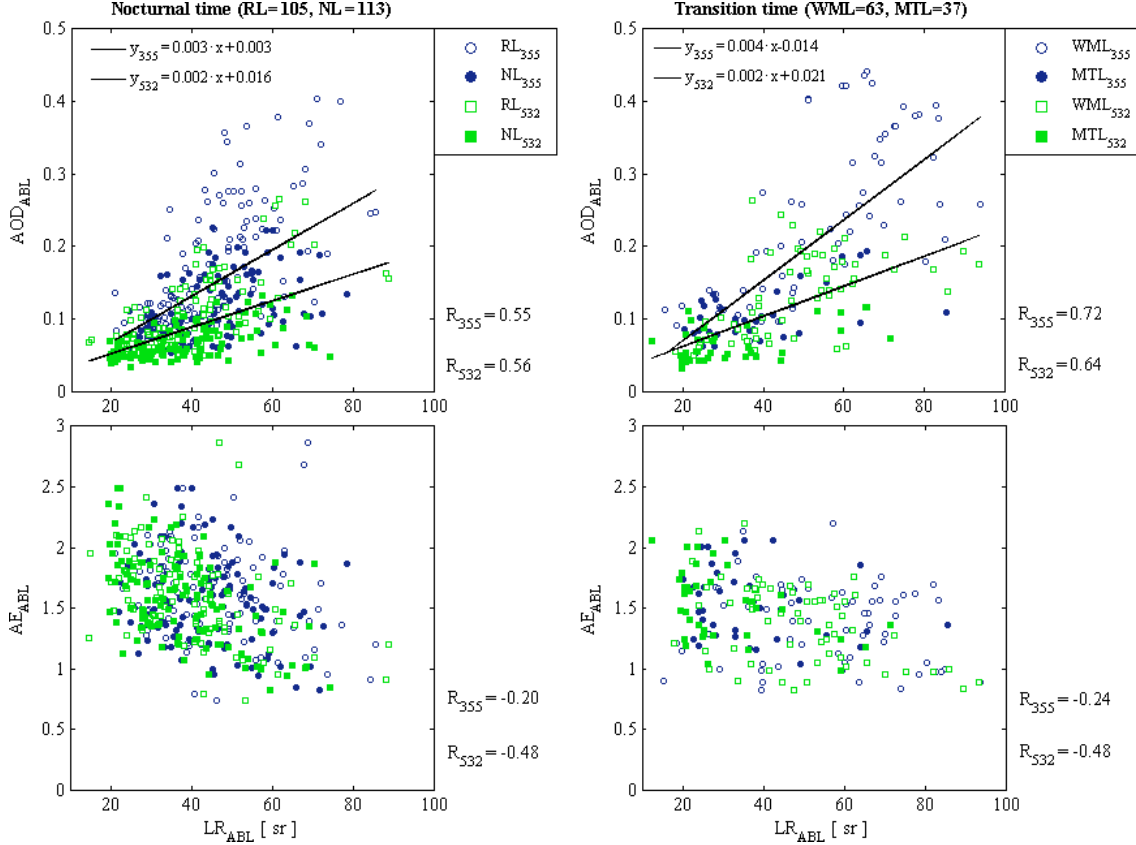
Figure 8. Hourly averaged aerosol optical depth (AOD), Ångström exponent (ÅE), and lidar ratio (LR) derived within the atmospheric boundary layer at 355 and 532nm from the PollyXT lidar at the RS-Lab, at the EARLINET/ACTRIS site in Warsaw, for the July–September period of 2013, 2015, and 2016. The lack of a correlation between the linear particle depolarization ratio ( δ ) and the lidar ratio (LR) is not shown for brevity. The linear fit to data points is shown for correlation coefficients ( R ) greater than